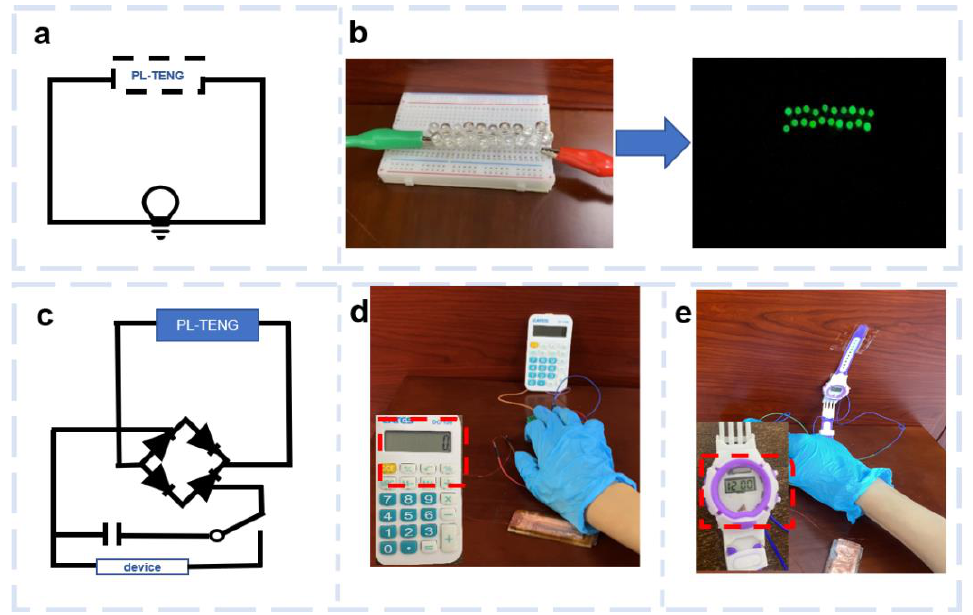
Figure 4. Application of the PL-TENG as a power supply. ( a ) Diagram of the PL-TENG lighting an LED circuit. ( b ) PL-TENG powering LEDs. ( c ) PL-TENG in the rectifier circuit. ( d ) PL-TENG as a calculator power supply. ( e ) PL-TENG as an electronic watch power supply.